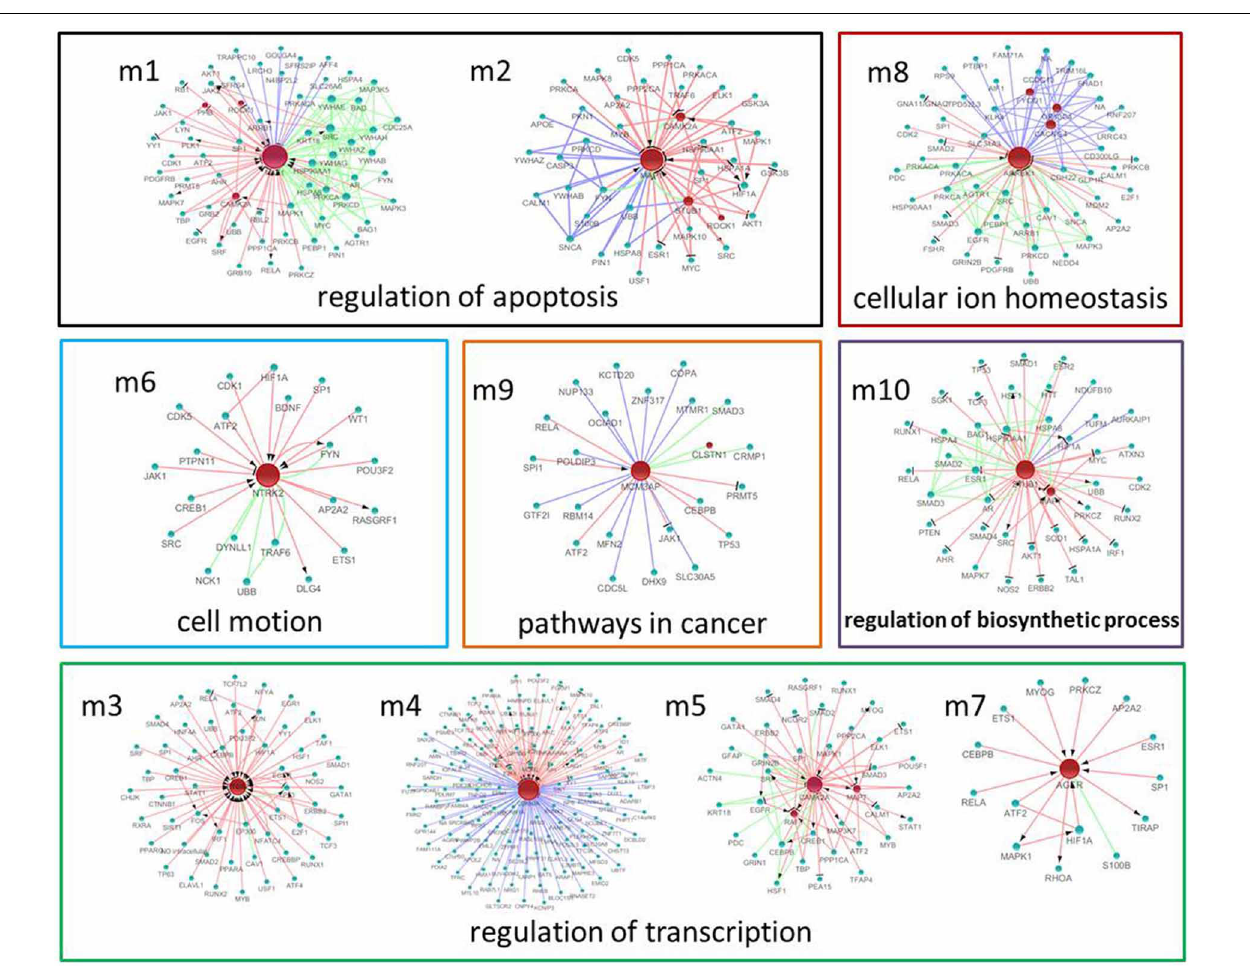
MetaCore, green line if they have interaction in PPI, and blue line if they are significant co-expressed. The red line with black arrow indicates activation. The red line with black small line segments indicates